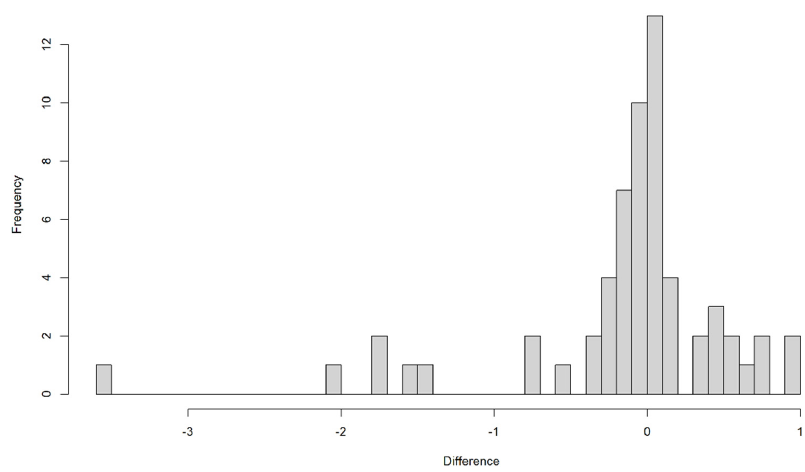
Figure 5. A histogram of differences for estimates of greenery for interior spaces obtained from the manual and automated methods. Table 3. Linear regression models with empirical support (i.e., ∆ AICc ≤ 2) that were used to predict differences in greenery for interior spaces estimated using manual and automated methods. A “+” symbol indicates the variable was included in the model.